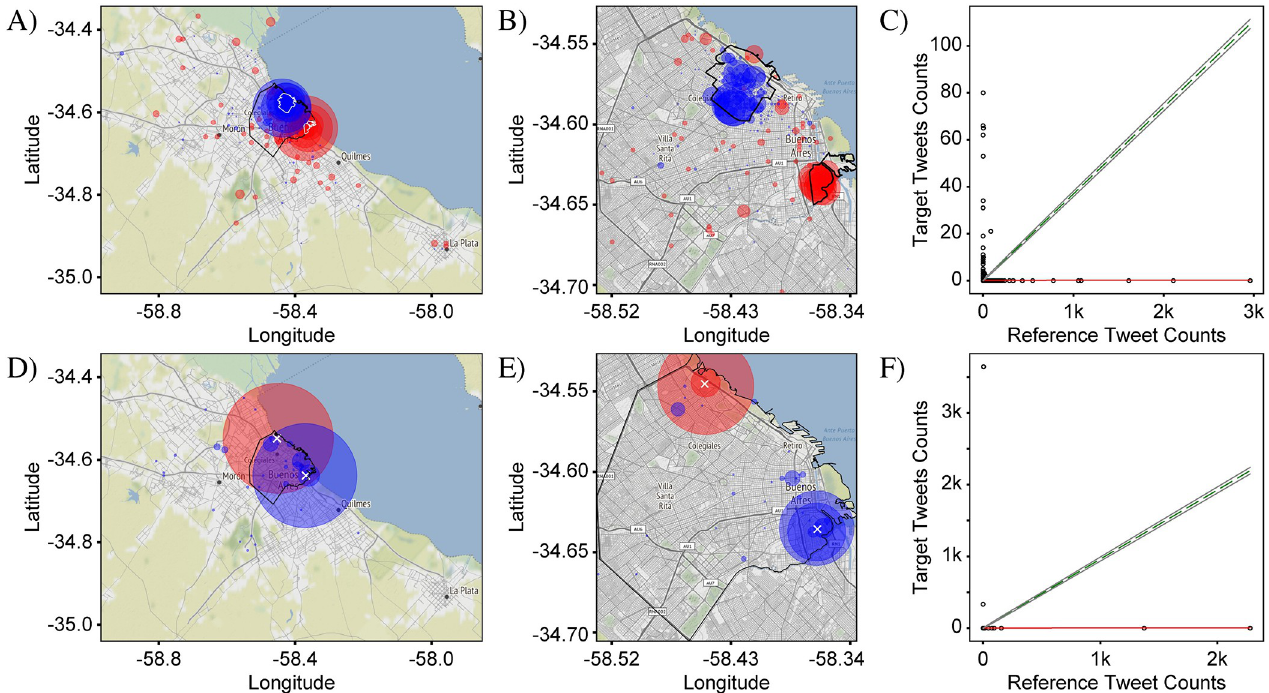
Fig 6. Neighborhood names and location names cases. (A) & (B) Differential distribution of neighborhood names “La Boca” and “Palermo” plotted over the extents of CABA+ and CABA, respectively. Blue (red) circles show where “Palermo” (“La Boca”) is more prominently used. The distributions show that tweets mentioning the neighborhood names are highly localized to the neighborhoods themselves which in (A) are delineated by white outlines and in (B) by black outlines. These figures also show that of the two neighborhoods, La Boca is more likely to be mentioned by tweeters outside the confines of the two. (C) “Frequency-comparison plot” for the data in (B) showing that the counts of tweets mentioning “Palermo” almost perfectly anticorrelate to counts of tweets mentioning “La Boca”. This anticorrelation indicates a very strong spatial influence on the tweeting, with few bins having tweets mentioning both neighborhoods. CABA+ Statistics N T = 632, N R = 16,062, S PCC = 0.998, KSS = 0.87, GMI = 1.07. For CABA Statistics: N T = 590, N R = 15,967, S PCC = 0.999, KSS = 0.89, GMI = 0.70. (D) & (E) Differential distribution of the two most important soccer stadium names “La Bombonera” and “‘Monumental’ Antonio Liberti V” in CABA+ and CABA, respectively. Blue (red) circles show where “La Bombonera” (“‘Monumental’ Antonio Liberti V”) is more prominently tweeted. As with neighborhood names, tweets mentioning the stadiums almost exclusively come from the location of the stadiums themselves (marked by white crosses), indicating that being in the presence of the stadium is a strong driver for tweeting about it. In particular, “‘Monumental’ Antonio Liberti V” is only mentioned in two bins, both of which are in the immediate vicinity (or even within) the stadium. “La Bombonera” is mentioned slightly more extensively, but not dramatically so. (F) “Frequency-comparison plot” for the data in (E) showing that the counts of tweets mentioning the two stadiums almost perfectly anticorrelate to each other. CABA+ Statistics: N T = 3,978, N R = 744,539, S PCC = 0.999, KSS = 0.998, GMI = 0.06. CABA Statistics: N T = 3,978, N R = 4,131, S PCC = 0.999, KSS = 0.999, GMI = 0.65. Base map and data from OpenStreetMap and OpenStreetMap Foundation under the Open Database License (Fig 6A, 6B, 6D and